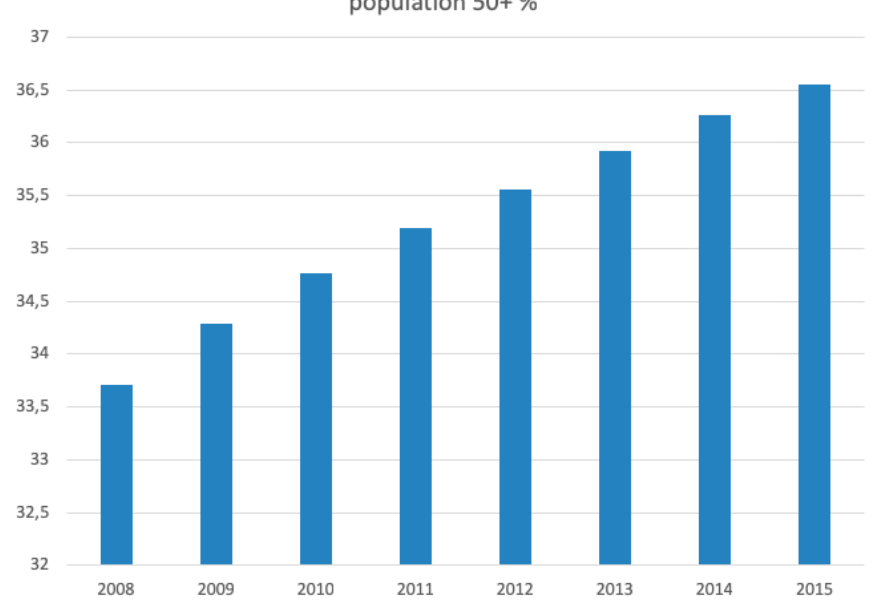
Figure 12. Percentage of population aged 50 years or older in Poland during the study period.